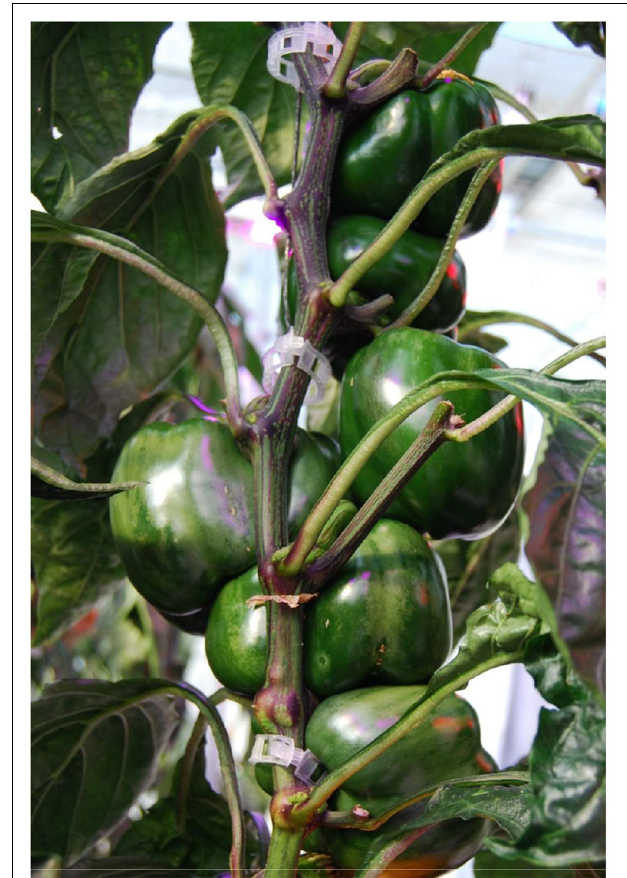
FIGURE 1 | Fruit stacking due to short internodes in plants grown under supplemental